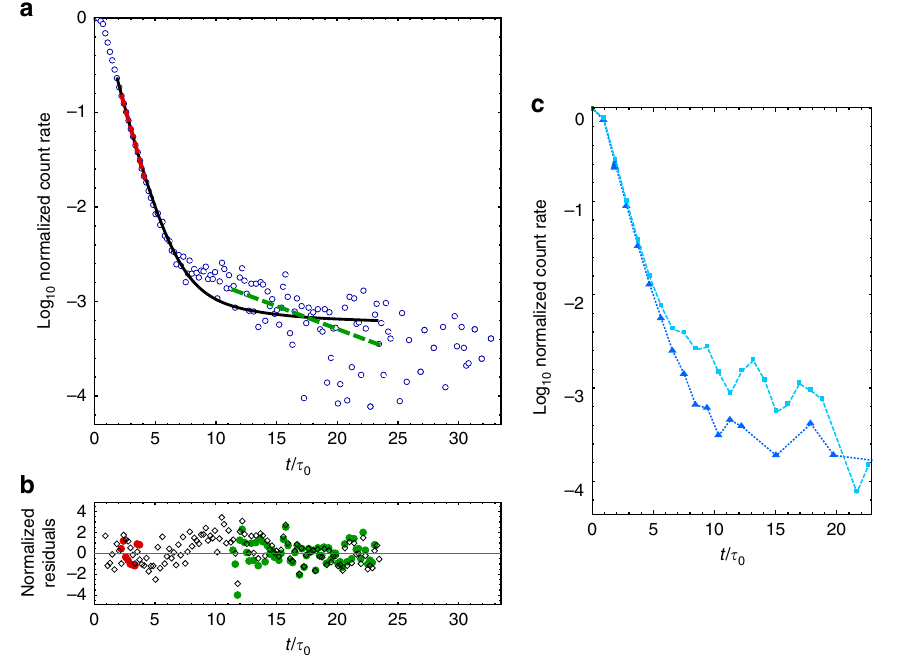
Fig. 2 Measured super- and sub-radiant decay of excited atoms near the optical nano fi ber. a Normalized rate of photons detected through the ONF mode (blue circles in a logarithmic scale) as a function of time in units of natural lifetime ( τ 0 = 1/ γ 0 = 26.24 ns) with 5 ns bins. The signal is taken after a probe beam polarized along the nano fi ber turns off. In this realization OD = 0.66 ± 0.05. The individual statistical error bars are not plotted but they are taken into account for the normalized residuals in b . The number of counts at t = 0 exceeds 10 6 . We see two distinct slopes (red and green), at short and long times. The initial slope (red) deviates toward decay rates faster than γ 0 , a signature of super-radiance. The second slope (green) comes from the natural post-selection of purely sub-radiant states. The red dashed (green dashed) line is the best fi t to a pure exponential decay of the initial ( fi nal) decay. The decay rate of the fi t at short times is 1.10 ± 0.02 γ 0 , and 0.13 ± 0.01 γ 0 for the fi t at longer times, with one-sigma error. The one-sigma fractional systematic errors are ± 0.01. The full description of the measured temporal evolution of the system involves averaging over many different decay rates through Monte Carlo methods (explained in “ Methods ” section). The solid black line is a simulation of 7 atoms along the ONF, with reduced χ 2 of 1.60. b The red circles, green circles, and black diamonds are the normalized residuals of the exponential fi ts to the initial decay, fi nal decay, and the theoretical model. c Shows two different decay signals from an excitation driving the atoms with light polarized along (cyan rectangles) and perpendicular (blue triangles) to the ONF for 25 ns bins. When the driving fi eld is polarized along the ONF, we observe super- and sub-radiance, and when it is polarized perpendicular to the ONF the super-radiance increases and the sub-radiance decreases. This feature is qualitatively captured by the theoretical